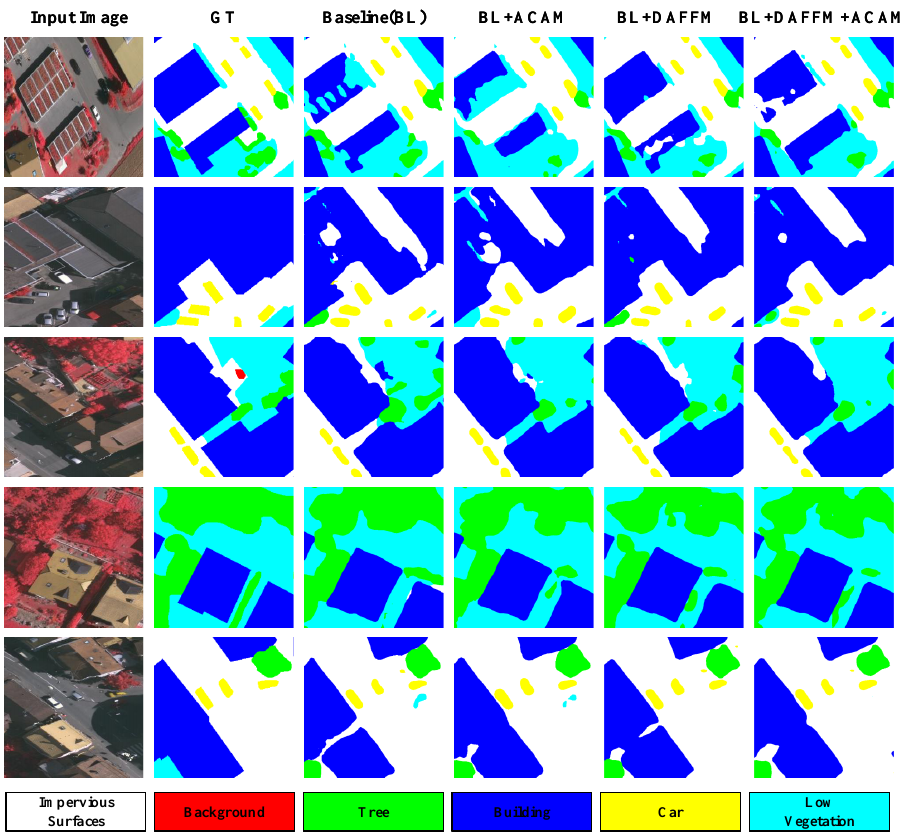
Figure 5. Visualization of the segmentation results for ablation study. From left to right, the input image, the ground-truth segmentations, and the results from variants of our methods.